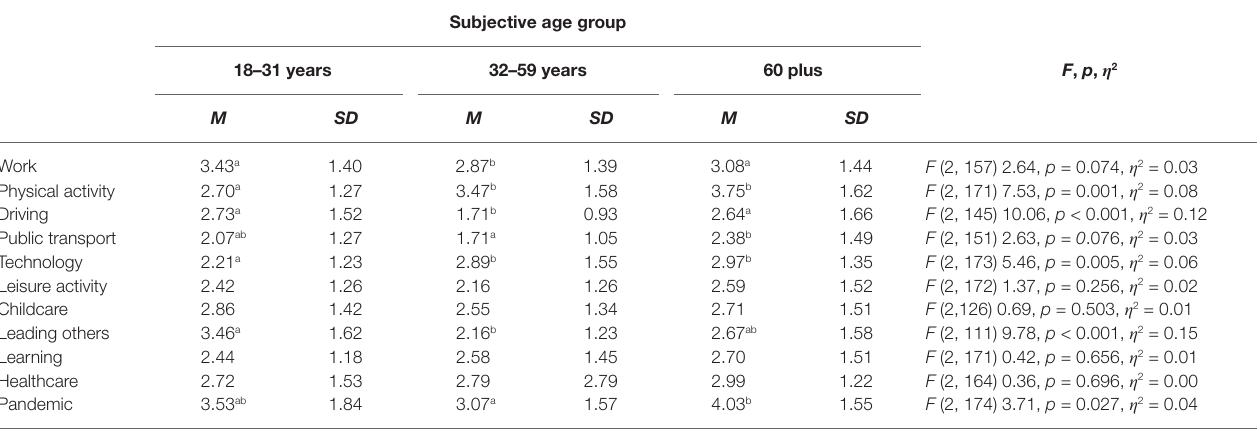
Different letters in the same row indicate significant pairwise comparisons p <